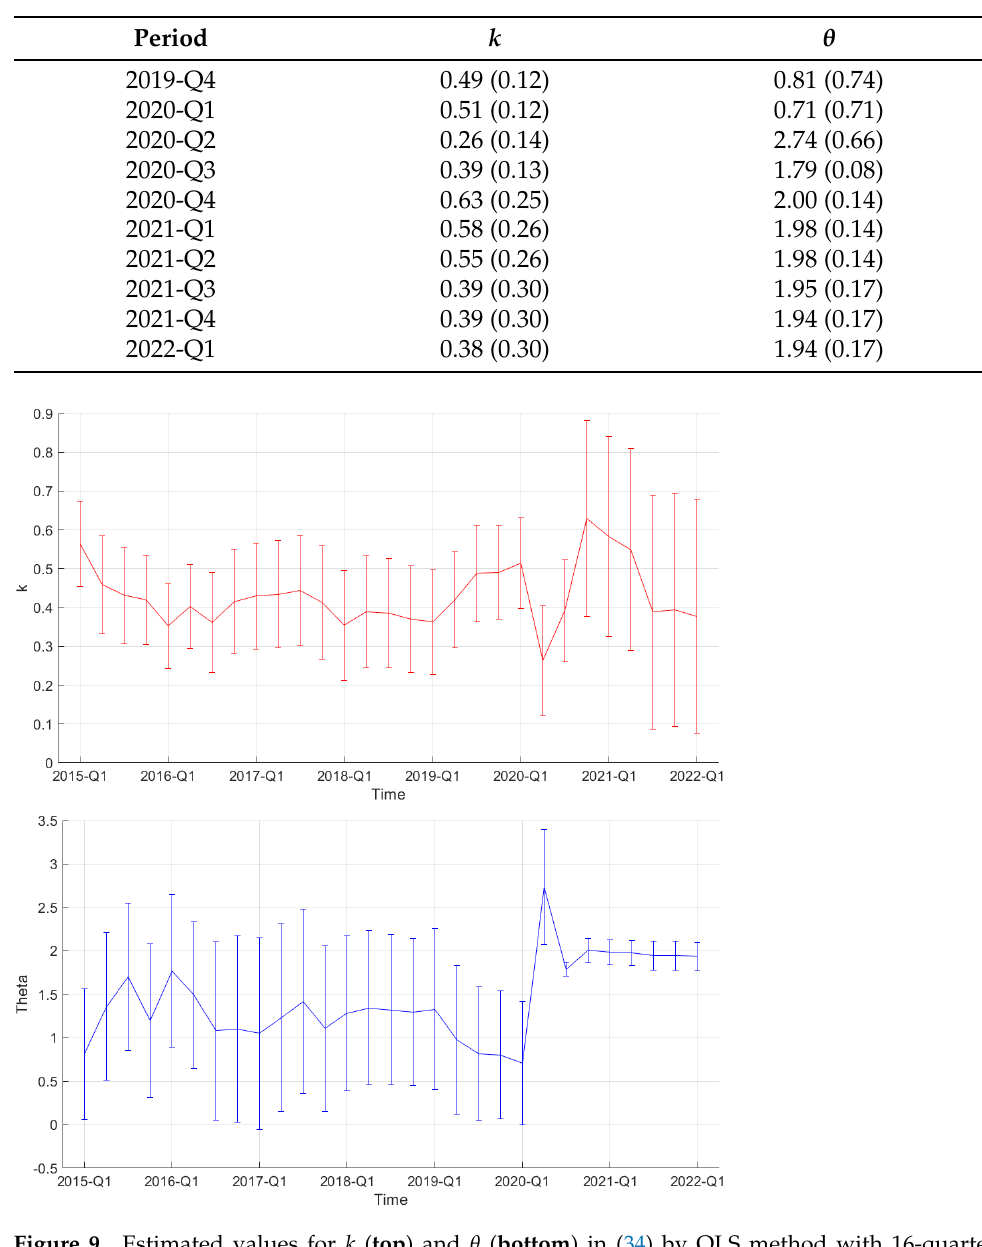
Figure 9. Estimated values for k ( top ) and θ ( bottom ) in (34) by OLS method with 16-quarter running